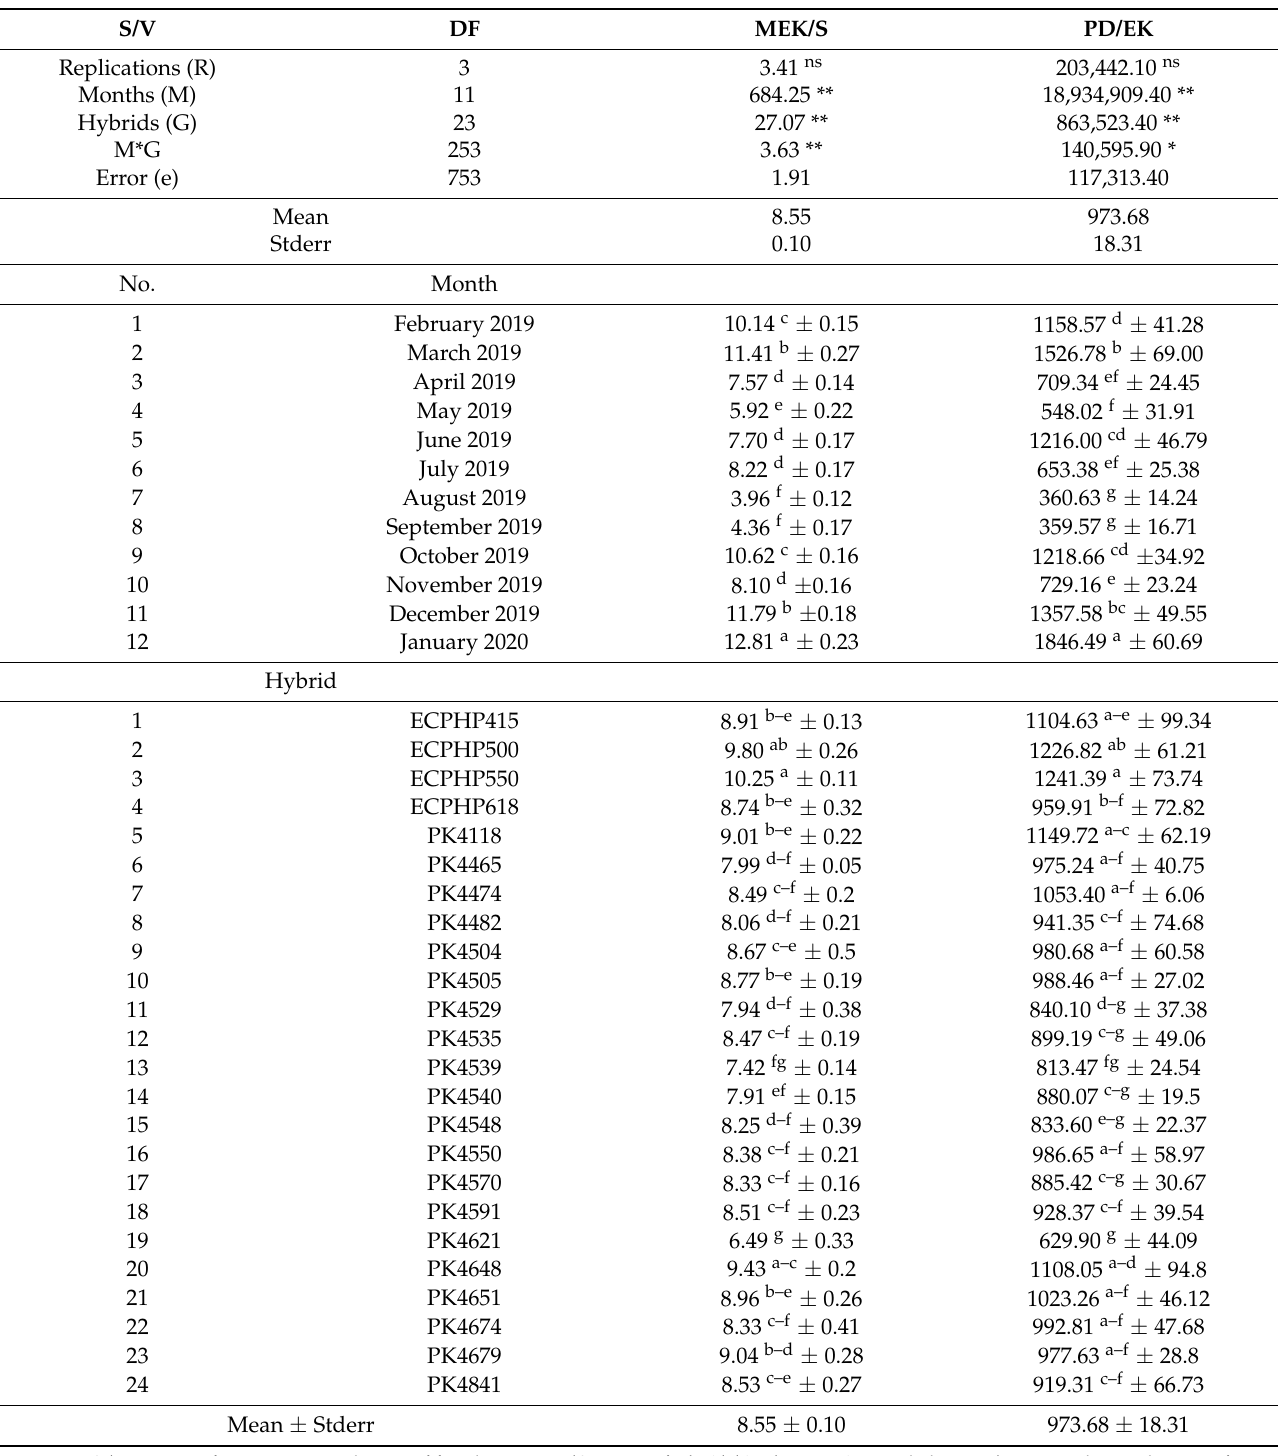
Table 3. Analysis of variance and monthly population mean ± standard error per spikelet and population density of E. kamerunicus in D × P